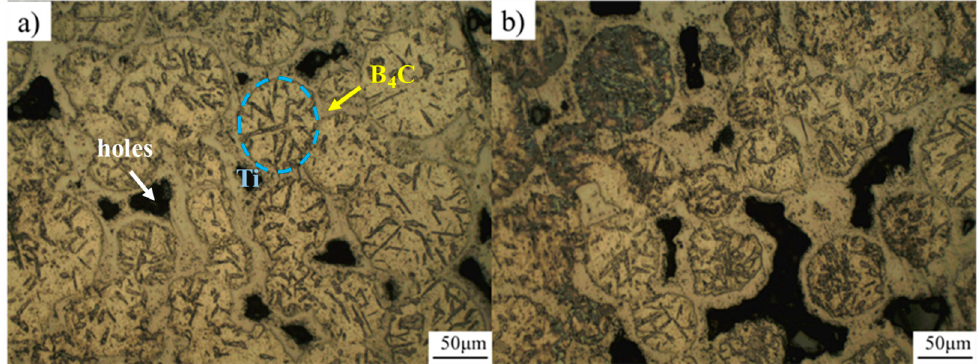
Figure 6. Metallographic characterization of Ti-B 4 C composites; ( a , b ) are the representation of different regions.